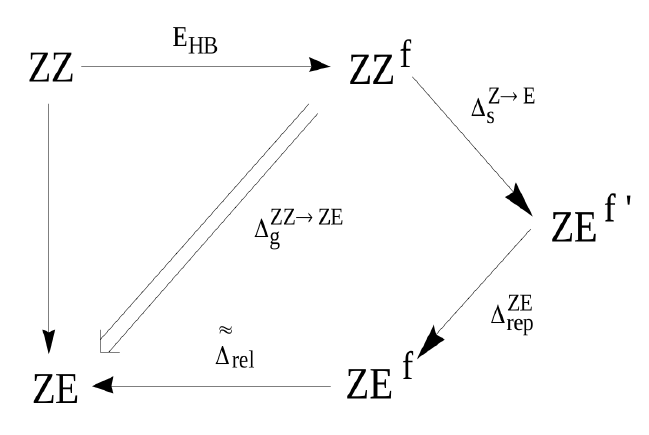
Figure 11. Diagram showing the way of obtaining the ZE conformer from the ZZ one through various fictitious